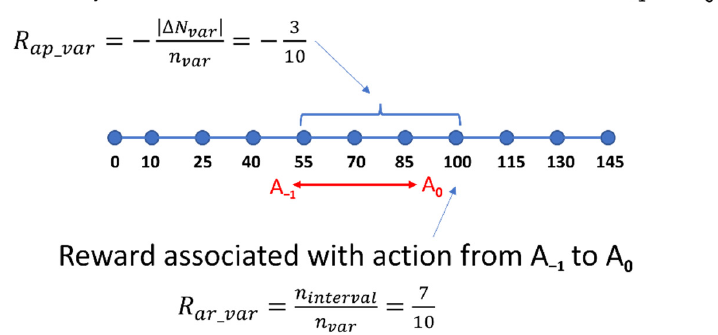
Figure 10. Example calculation of an action transition-based penalty and reward associated with action.